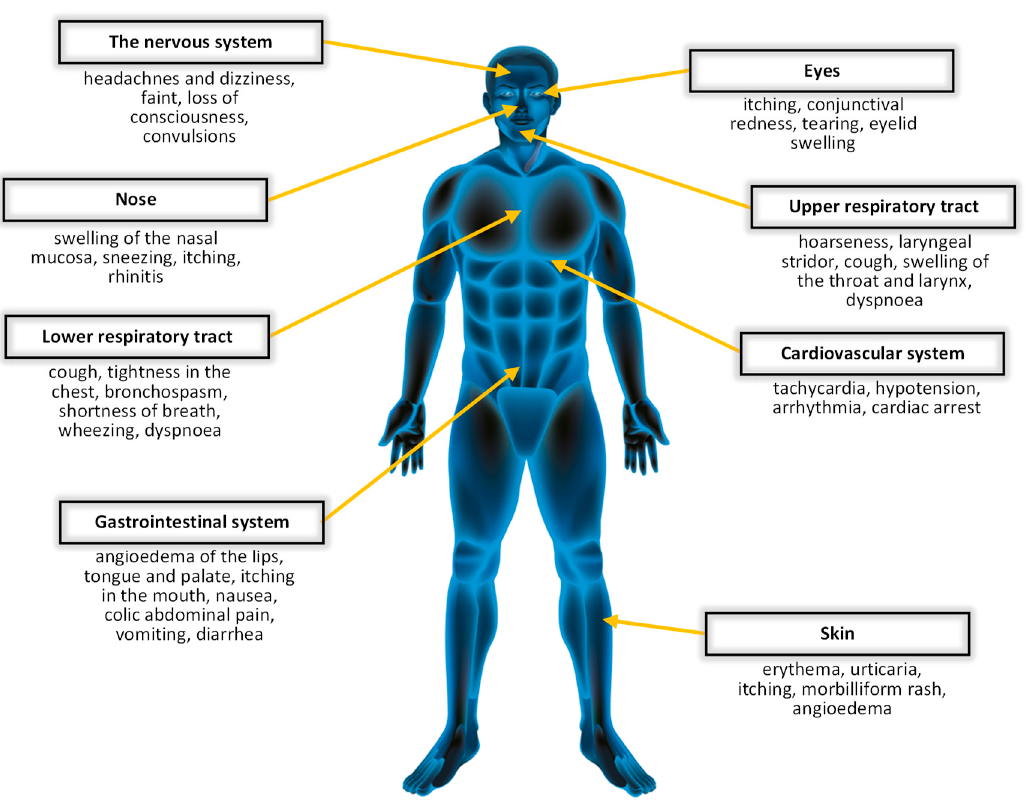
Figure 1. Allergic symptoms following a Hymenoptera sting.